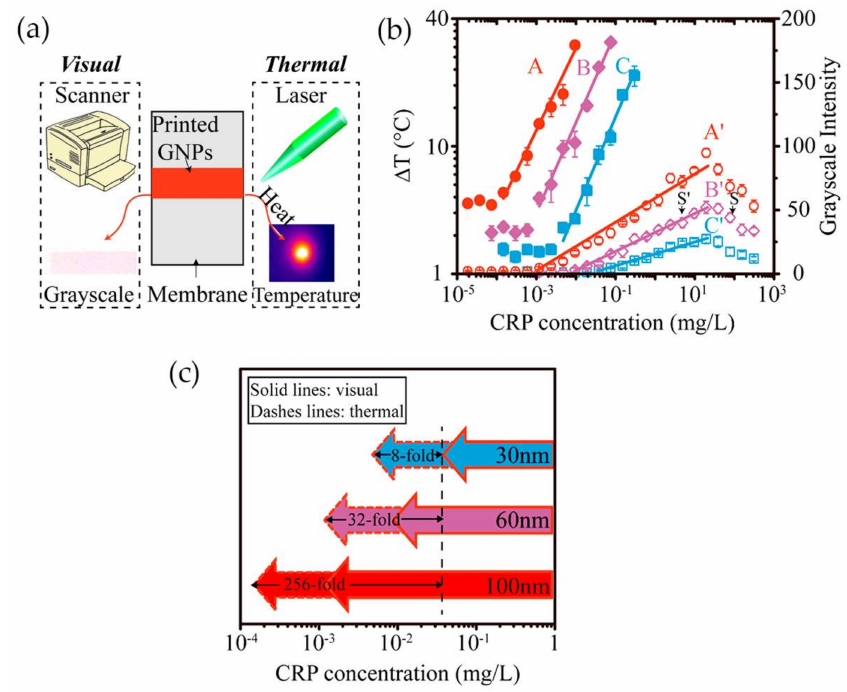
Figure 12. ( a ) The two methods used for evaluate CRP detection: visual and thermal; ( b ) Illustration of the correlation between temperature increment and grayscale intensity with CRP concentration; ( c ) Representation of thermal and visual detection of CRP on LFA, using Au NPs with 30, 60 and 100 nm of average size. Reproduced with permission from ref. [84]. Copyright American Chemical Society,